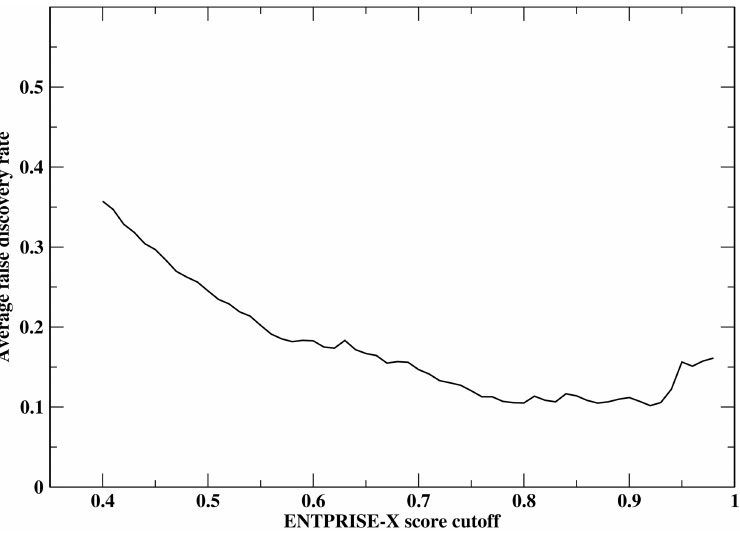
Fig 5. Dependence of average false discovery rate of ENTPRISE-X for 13 human exomes on score cutoffs.